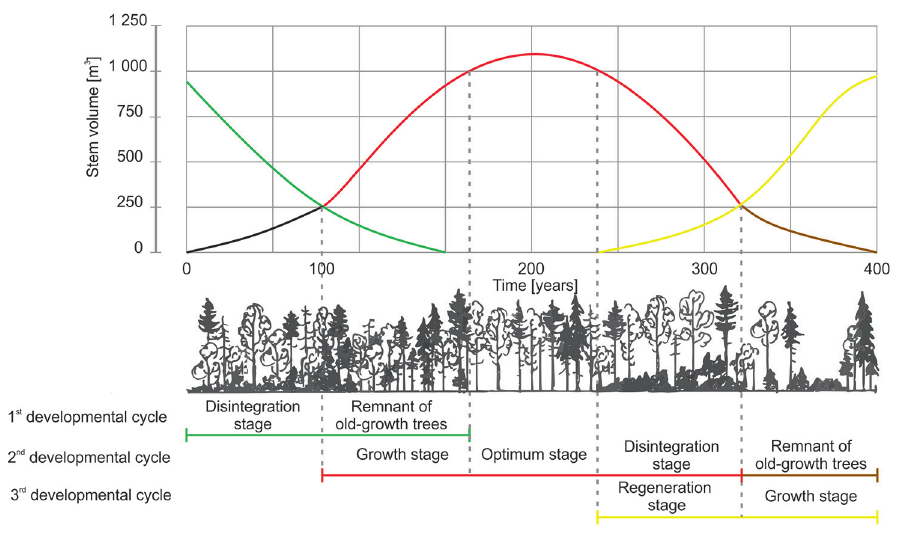
Figure A1. Mosaic of small development cycles in primeval beech-fir mountain forest – adapted from Korpel (1995), Natural Reserve Dobrocsky Prales, Slovak